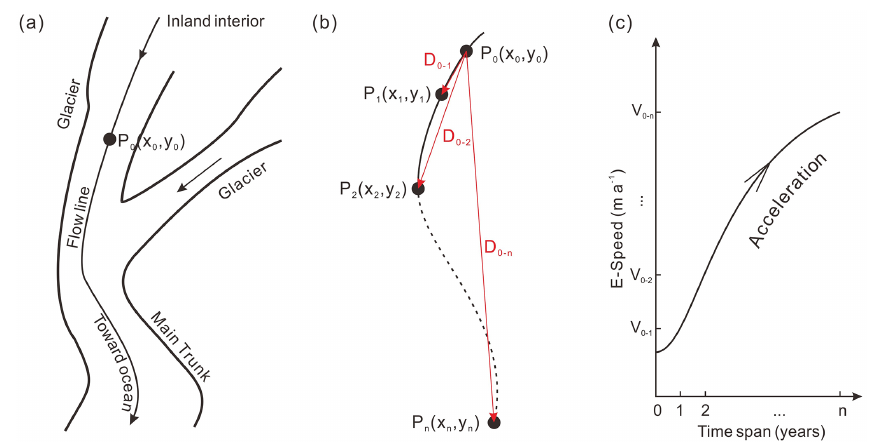
Figure 1. Illustration of acceleration-induced overestimation in a velocity map derived from a satellite image pair with a long time span: (a) schematic scene of accelerated ice flow in a glacier–ice-shelf system in AIS, (b) calculation of E velocities at P o (x o ,y o ) with an equal increment in time span (1 year), and (c) increase in E velocity at the same point P o (x o ,y o ) as the time span increases – the cause of the acceleration-induced velocity overestimation.